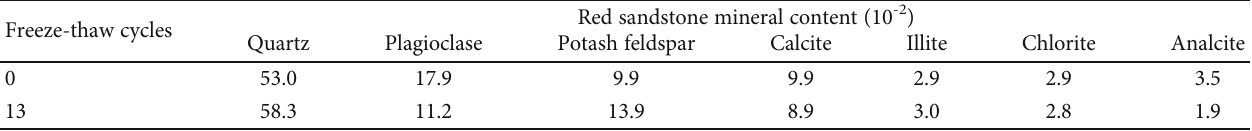
Table 4: X-ray di ff raction analysis results of red